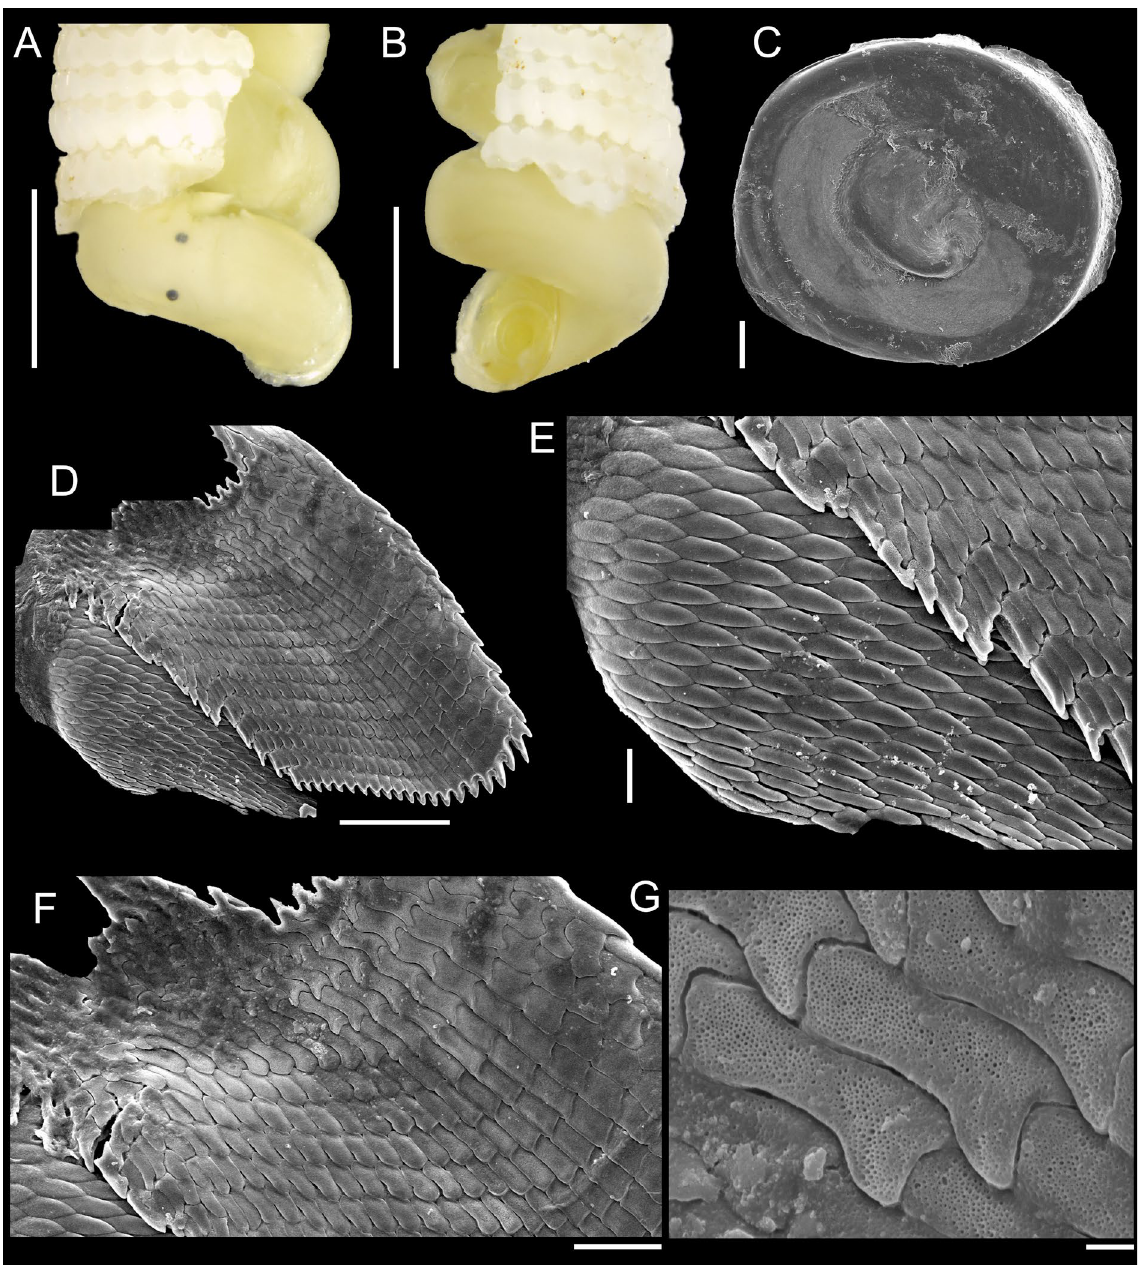
Fig. 12. Latitriphora albida (A. Adams, 1854). A–G . BMSM 55442. A–B . External morphology. C . Operculum. D–G . Jaw, both sides (D–E) and outer side (F–G). Scale bars: A–B = 1 mm; C = 100